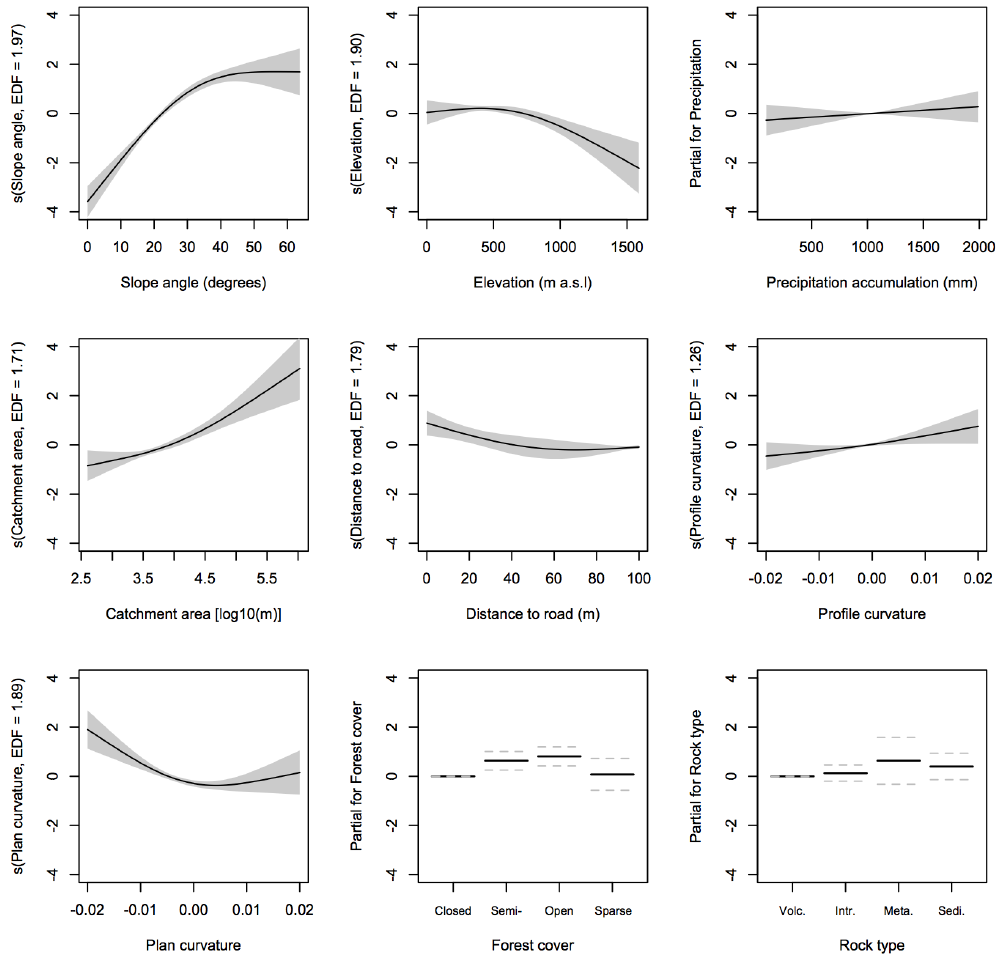
Figure 8. Transformation of predictor variables in the generalized additive model without an interaction term. Terms of the form s(predictor) indicate a nonlinear smoothing spline transformation. The effective degrees of freedom (EDF) refer to the flexibility of the smoothers, which were controlled with a maximum 3 EDF. The light grey bounding polygons (and dashed lines for categorical variables) represent confidence bands at a 95%